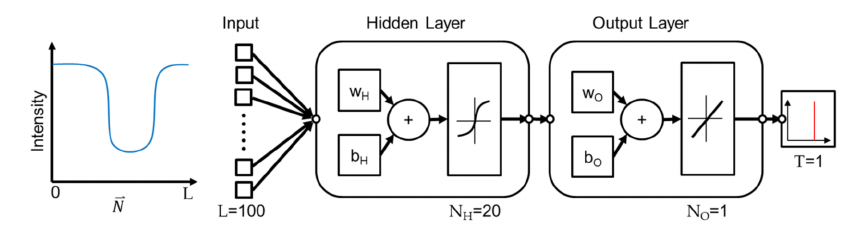
Figure 5. The structure of the neural